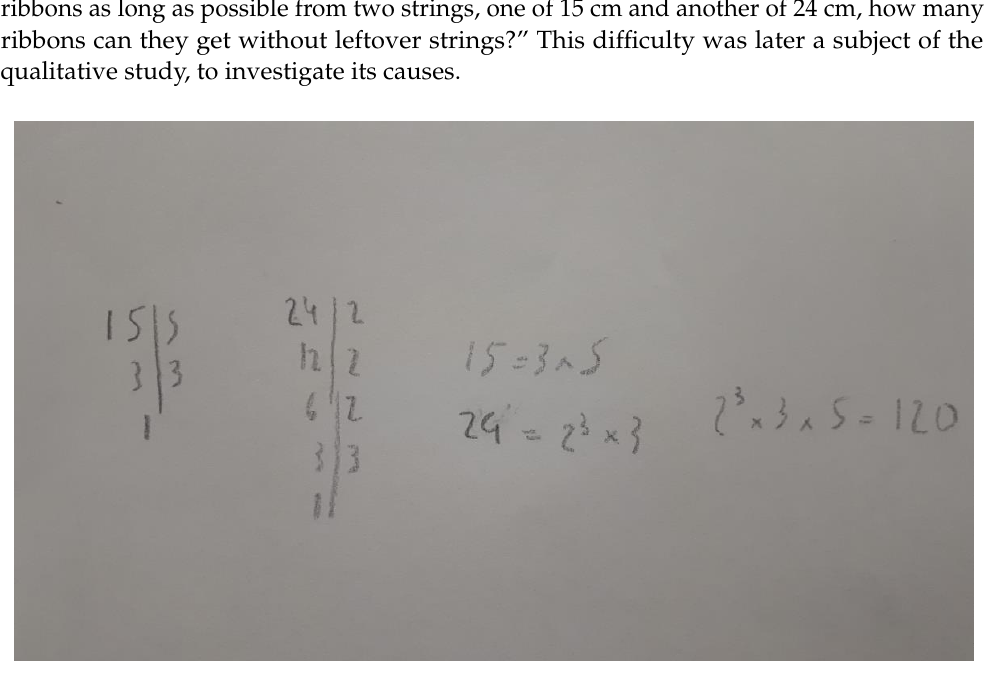
Figure 1. Example of answer calculating l.c.m. for GCDDL problem.